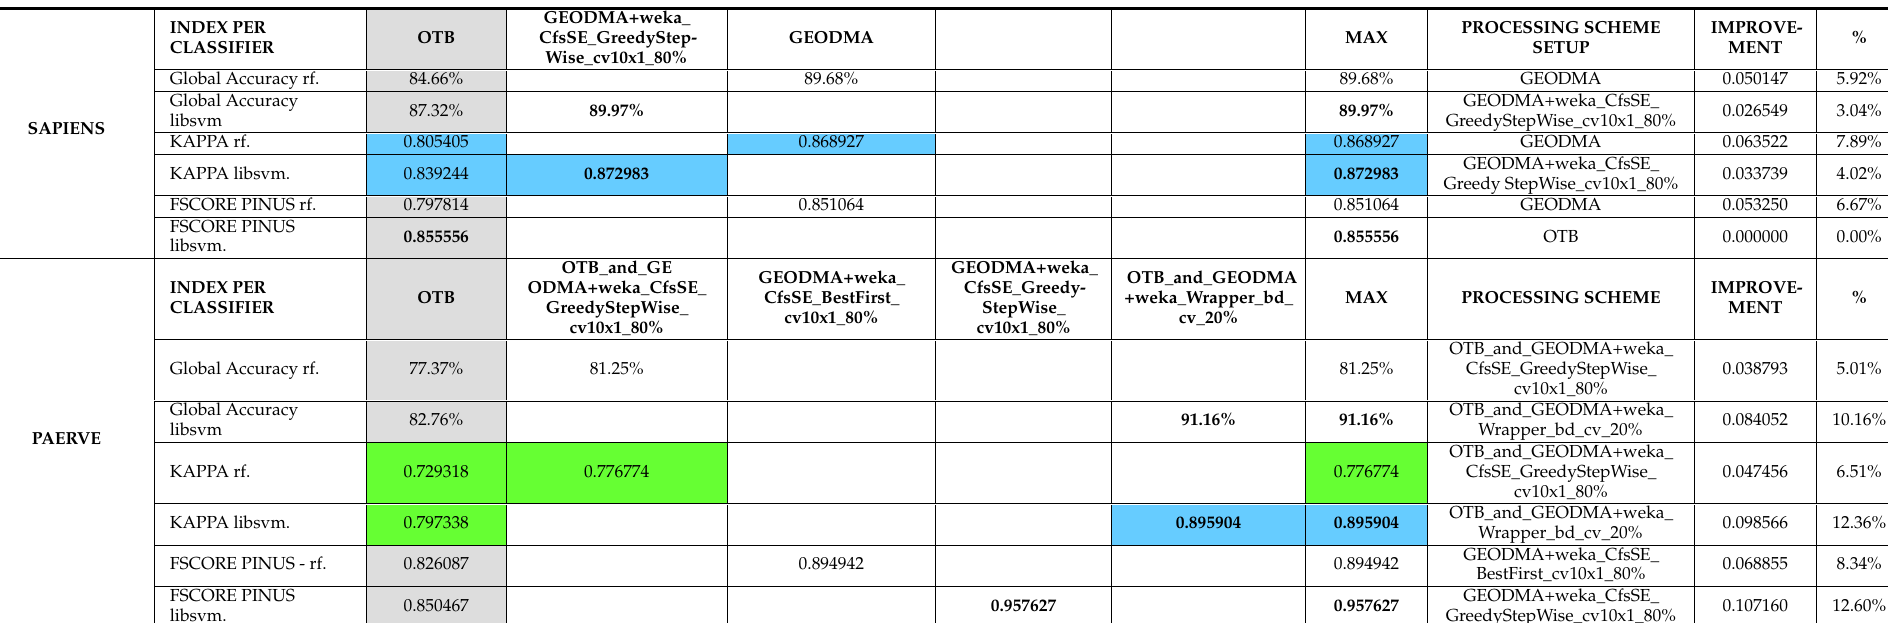
Table 6. High values for global accuracy, kappa index, and F-score of Class 1 ( Pinus sp.) reached for each classifier compared to those for the classifiers in the OTB software only. The highest values are in